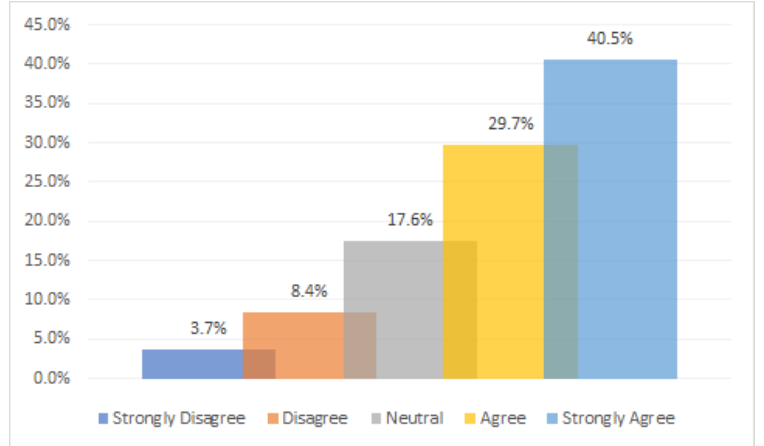
Figure 5. Answers to a Likert five-point scale to the question: Do you think team-working has helped you to enhance your motivation?